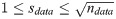
The fixed-step model has a maximal peak sharpness that can both prohibit data recapture and provide a diagnostic tool for when this occurs.(A) The sharpness of the output peaks for the synthetic data and fitted two and five-step models. The shaded regions show the sharpness bounds for the data (1≤sdata≤ndata) and the white diamonds highlight the parameter sets used for the example trajectory in (D). (B) The dimensionless dispersion of rate parameters of the data and fitted models compared to the sharpness of the data. We define the dispersion to be the standard deviation over the mean of the rate parameters of a single model instance. Zero dispersion means that all the rates equal one another. (C) The rate parameter dispersion compared to the length of the pathway that generated the data. (D) The time-course of the model instances marked as diamonds in (A-C).